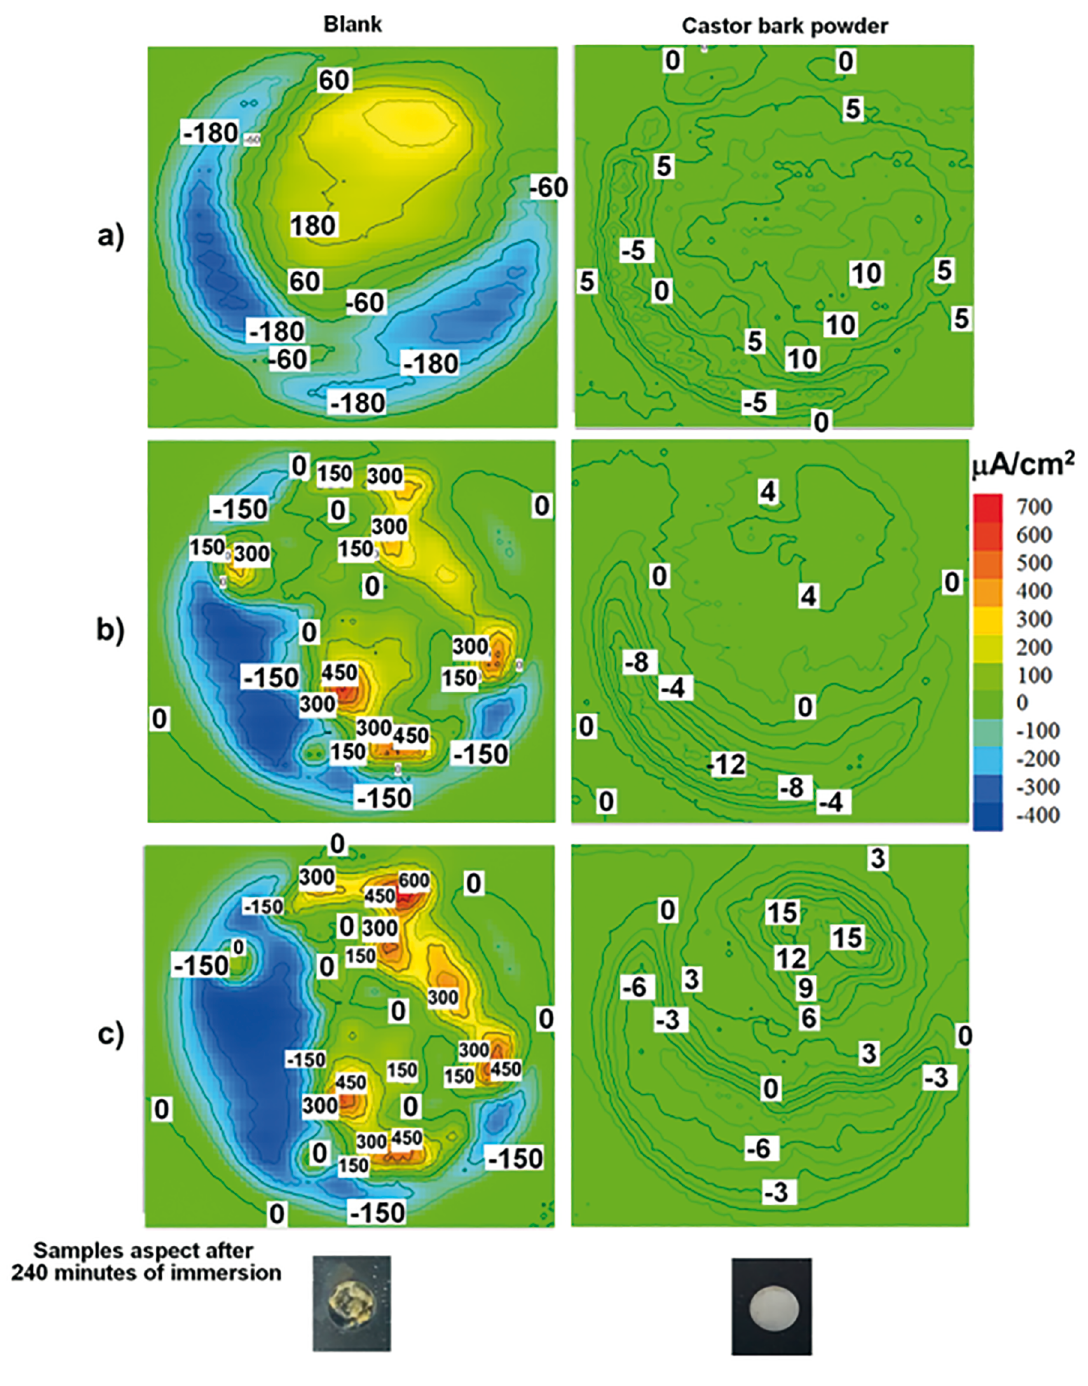
Figure 6. SVET ionic current maps for different immersion times for AISI 1020 carbon steel in absence and in the presence of castor bark powder in 1 x 10 -3 mol.L -1 HCl and the visual aspect of the samples after a) 2 min, b) 90 min and c) 240 min of immersion. castor bark powder. However, the cathodic current values with the blank solution. After 90 and 240 min of test, it can be were concentrated in one region of the sample, indicating observed that the behaviour is maintained, the ionic current that the adsorption process is not completely densities were lower than in the blank solution, proving the inhibitory action of the natural inhibitor leached from the